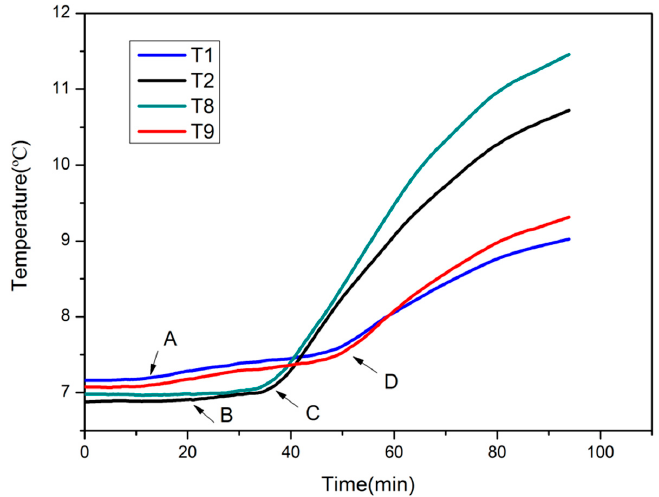
Figure 3. The temperature change curve of Run 3.